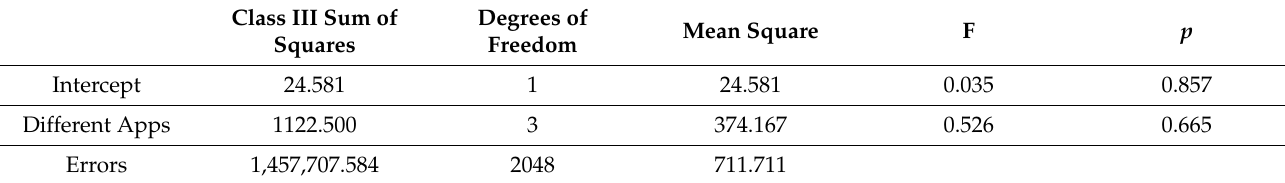
Table 12. ANOVA for brain region × APP.